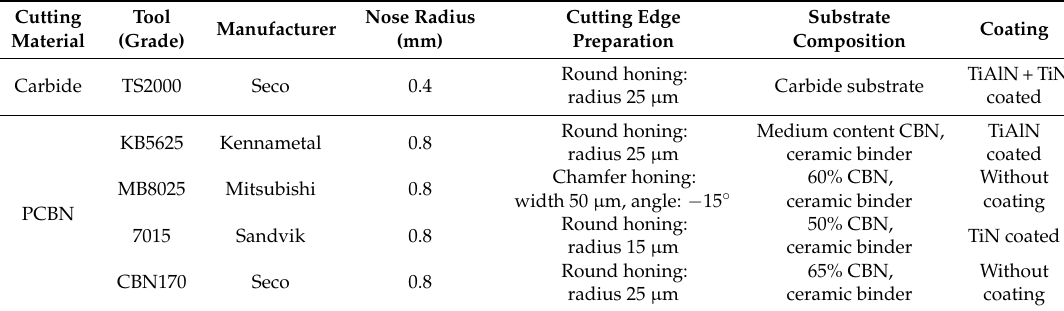
Table 2. Characteristics of the cutting tools: carbide tool used as a reference in conventional finishing operation in industry and different grades of PCBN